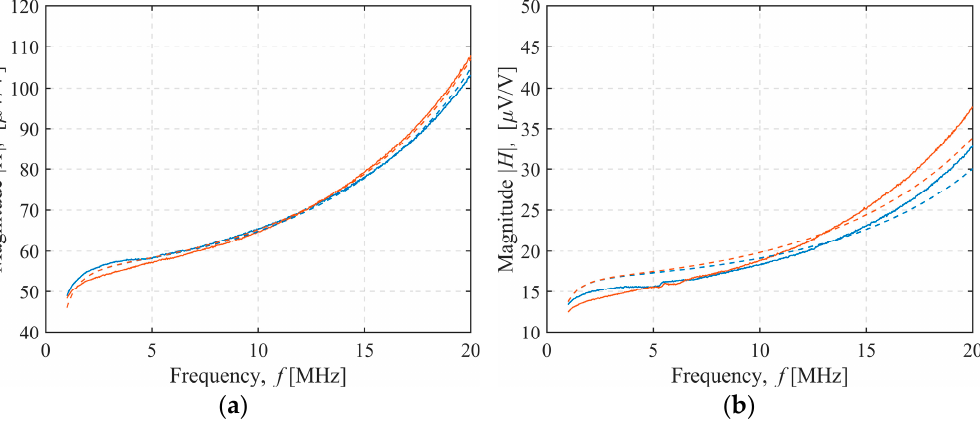
Figure 9. TX C-4/RX X-4 configuration sensor transfer function magnitude. Transmitter–receiver separation: ( a ) 27 cm, ( b ) 37 cm. Measurement (full line) and model results (dashed line). Transmitter orientation up (blue line) or down (red line).